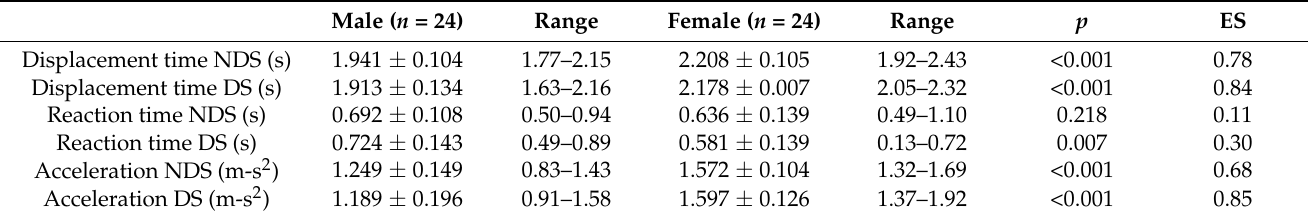
Table 5. Lateral displacement time, lateral acceleration and reaction time according to